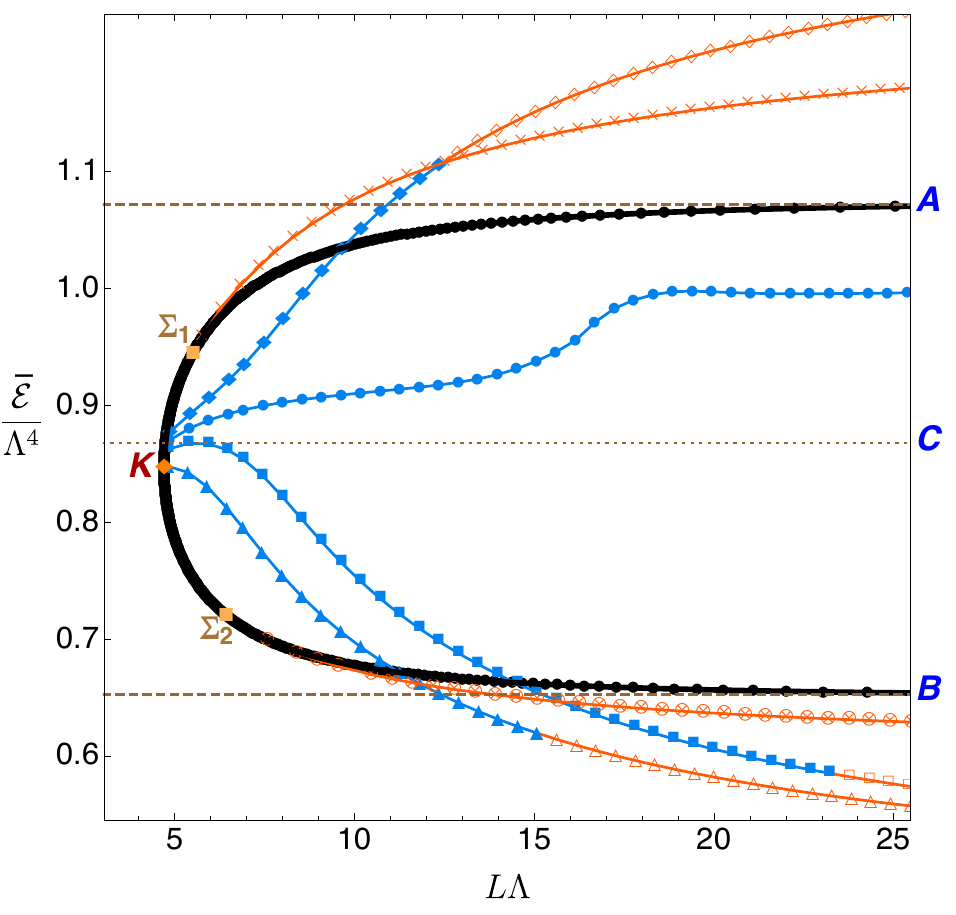
Figure 15 . Same stability diagram as in figure 8 with the inclusion of some lumpy-brane curves that bifurcate from the GL merger curve. These curves have constant ˆ T given by { ˆ T × , ˆ T ⊗ , ˆ T (cid:7) , ˆ T • , ˆ T (cid:4) , ˆ T N } ’ { 0 . 390711 , 0 . 405141 , 0 . 395420 , 0 . 395894 , 0 . 396367 , 0 . 397307 } . Solid